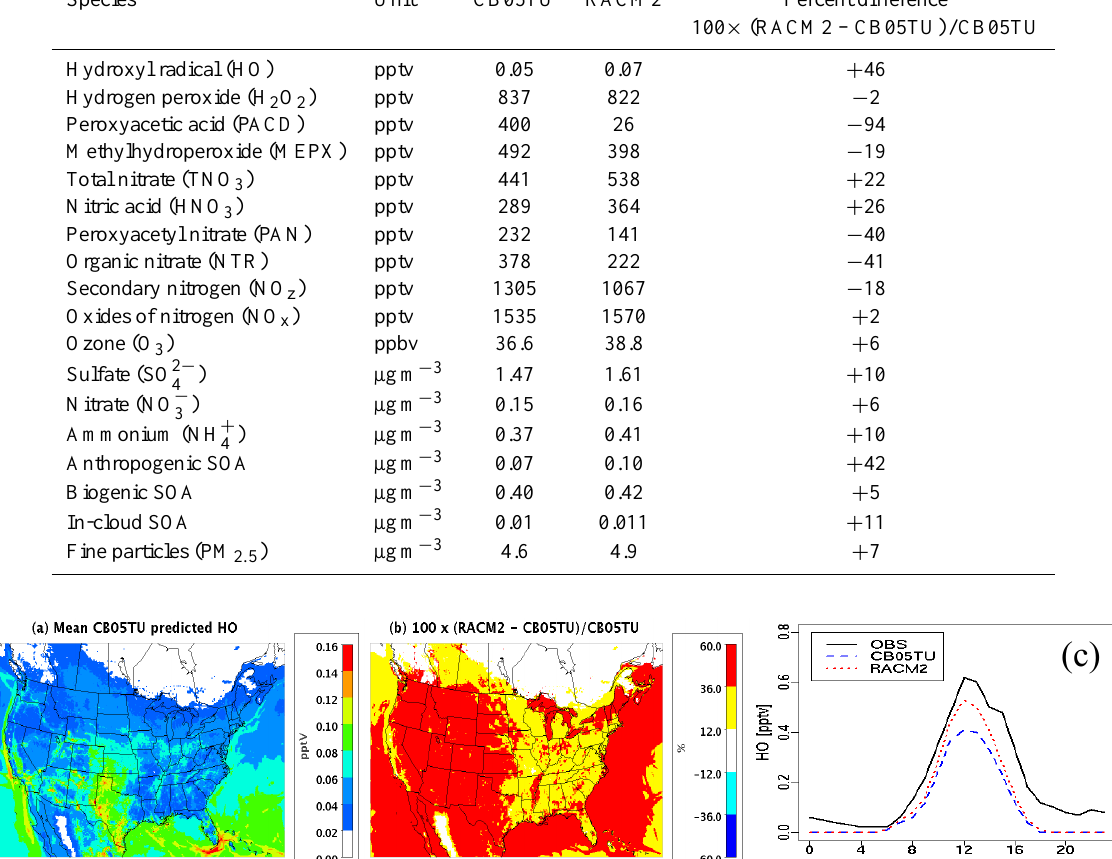
Fig. 1. (a) Predicted mean HO obtained with CB05TU, (b) percent differences in mean HO between RACM2 and CB05TU, (c) a comparison of predicted median HO to observed median data from the 2006 Texas Air Quality